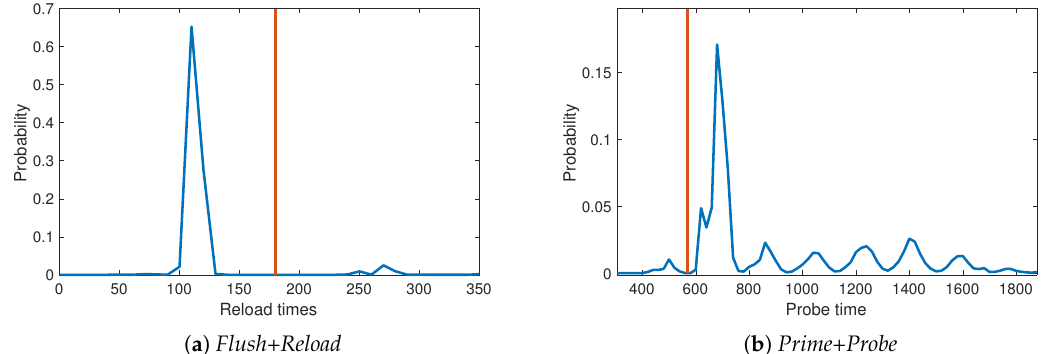
Figure 2. Timing information obtained when attacking AES in the Reload and Probe steps in our test machine. The threshold is shown in